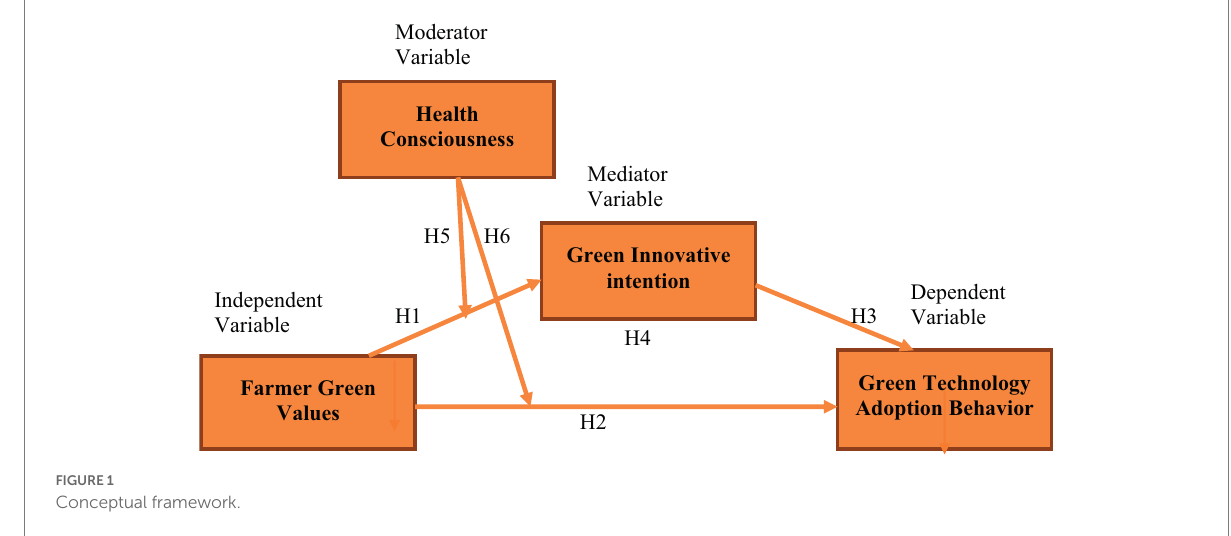
FIGURE 1 Conceptual